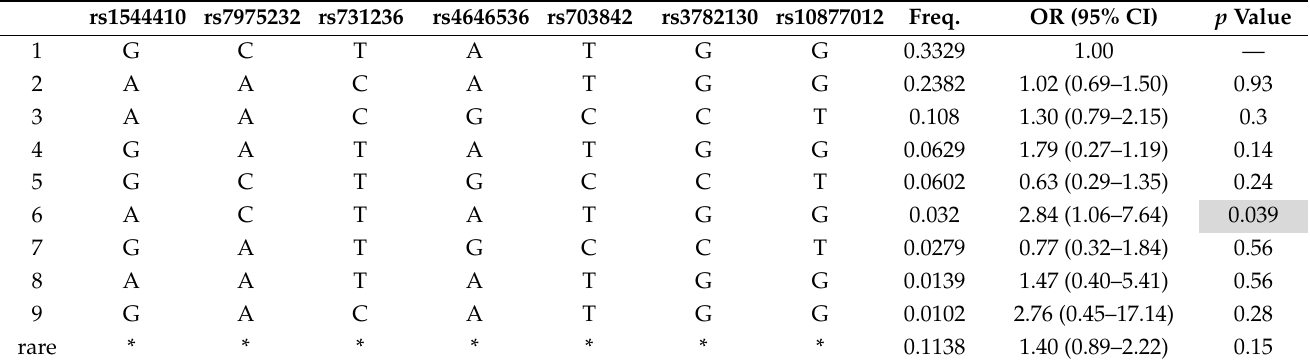
Table 5. Haplotype association with susceptibility to